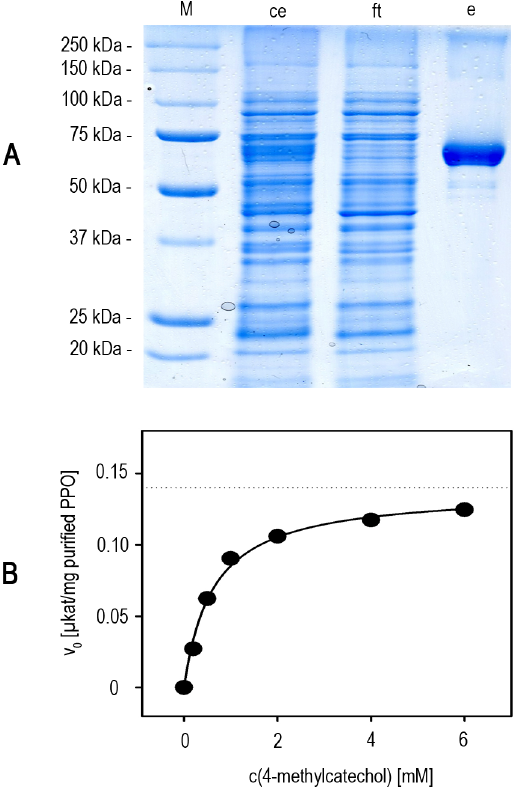
Figure 3. Heterologous expression of ToPPO-2. A Purification via Strep-Tactin-affinity chromatography. SDS-PAGE analysis was performed and proteins were stained by Coomassie Brilliant Blue. M: protein standard; ce: crude extract; ft: flow-through fraction; e: elution fraction. B PPO-kinetics on 4-methylcatechol. An example of a typical curve is shown. Non linear regression to the Michaels-Menten equation was performed (R 2 = 0.99) to gain values for v max (0.14 6 0.004 m kat per purified PPO; dotted line ) and K m (0.62 6 0.07